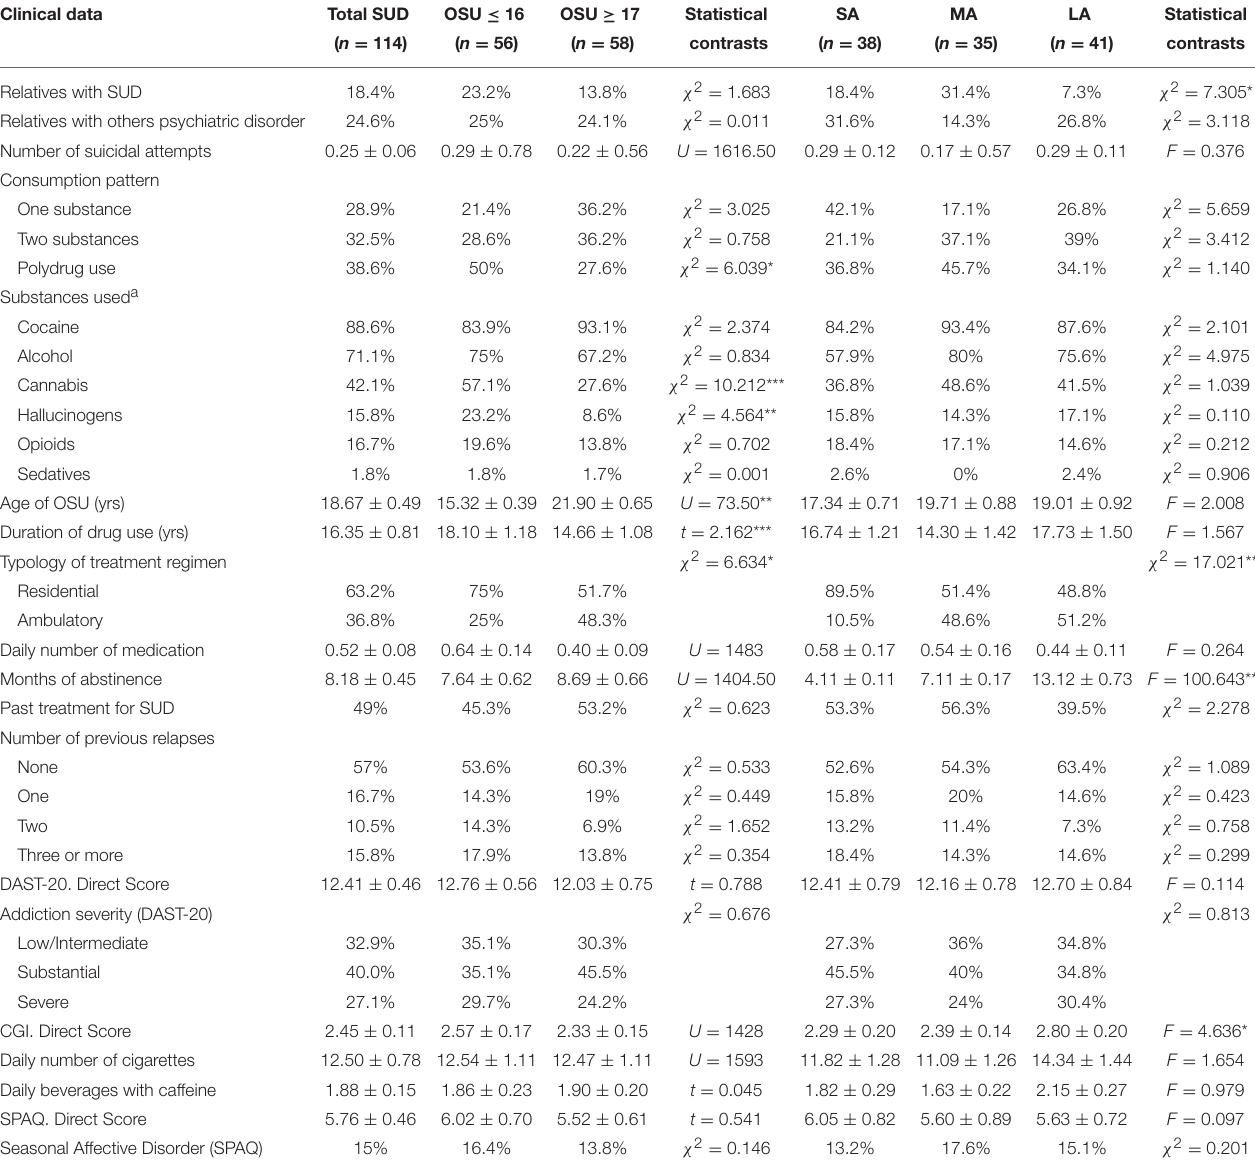
TABLE 2 | Clinical data for the whole SUD sample and all their